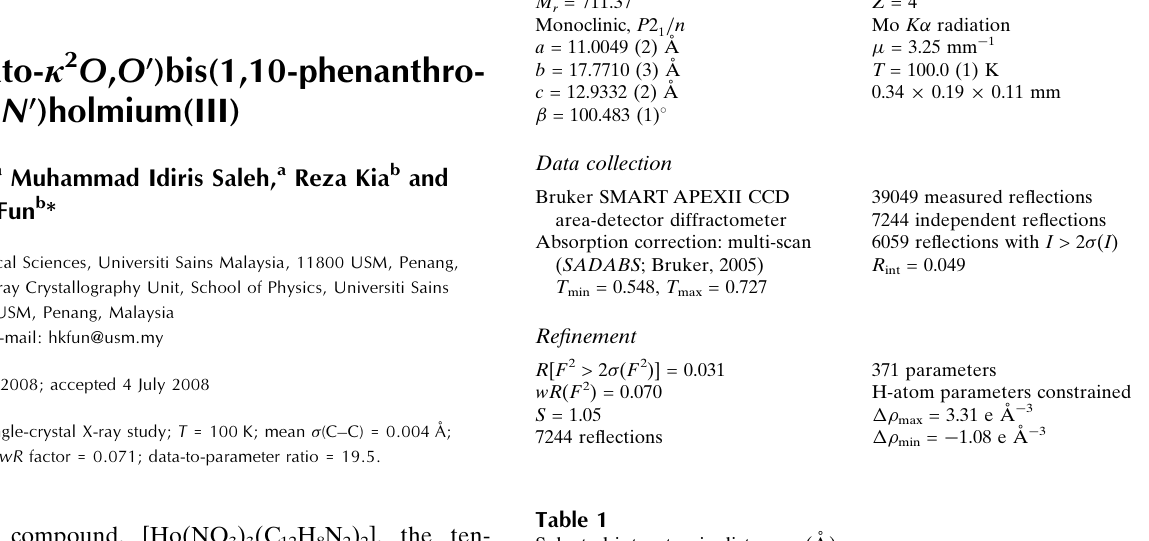
Selected interatomic distances (A˚ ).